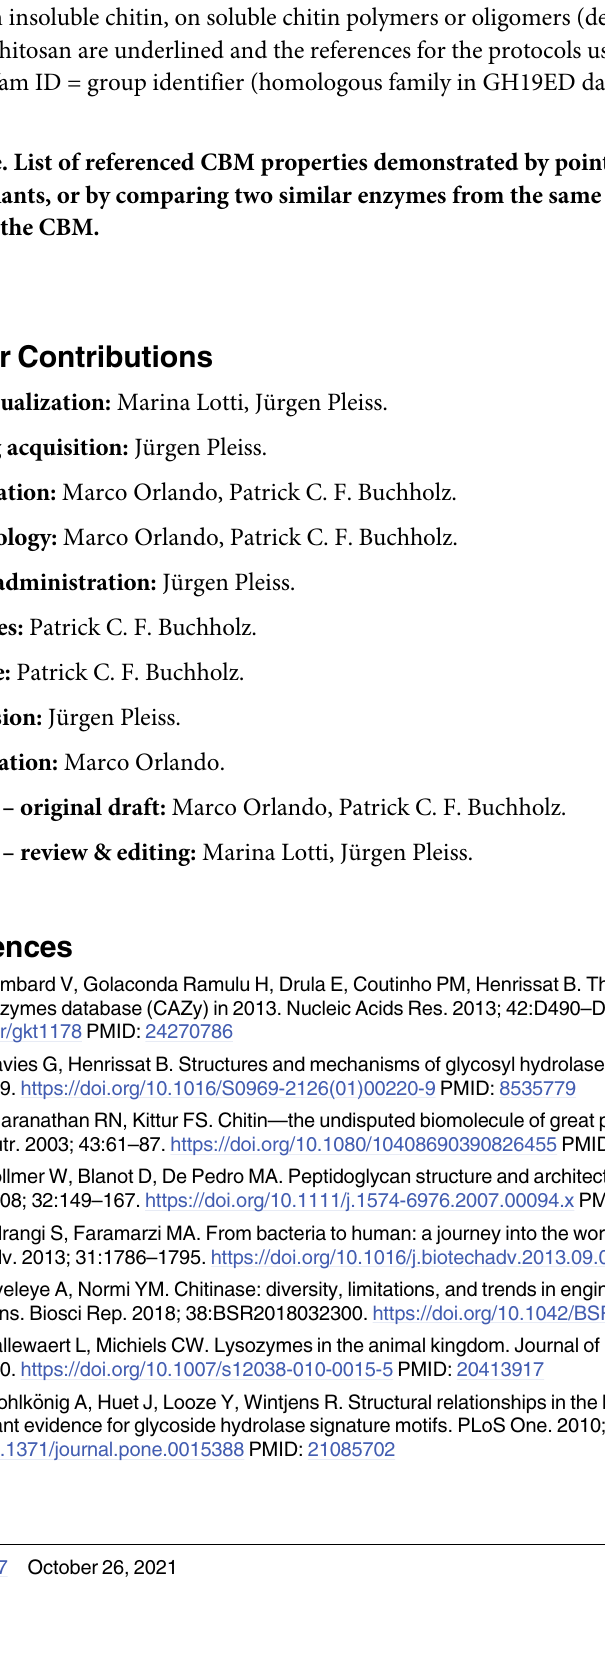
S8 Table. List of the substrates in which GH19 CHIT seed sequences are active with notes on their activity. Subfamily groups assignment and numeral identifiers are based on Fig 3A and 3B . The sequences in which the effect of CBMs on catalytic and antifungal activity was tested are highlighted in bold. The Uniprot accession of sequences in which the activity was tested on insoluble chitin, on soluble chitin polymers or oligomers (derivatives comprised), and on chitosan are underlined and the references for the protocols used are reported in the